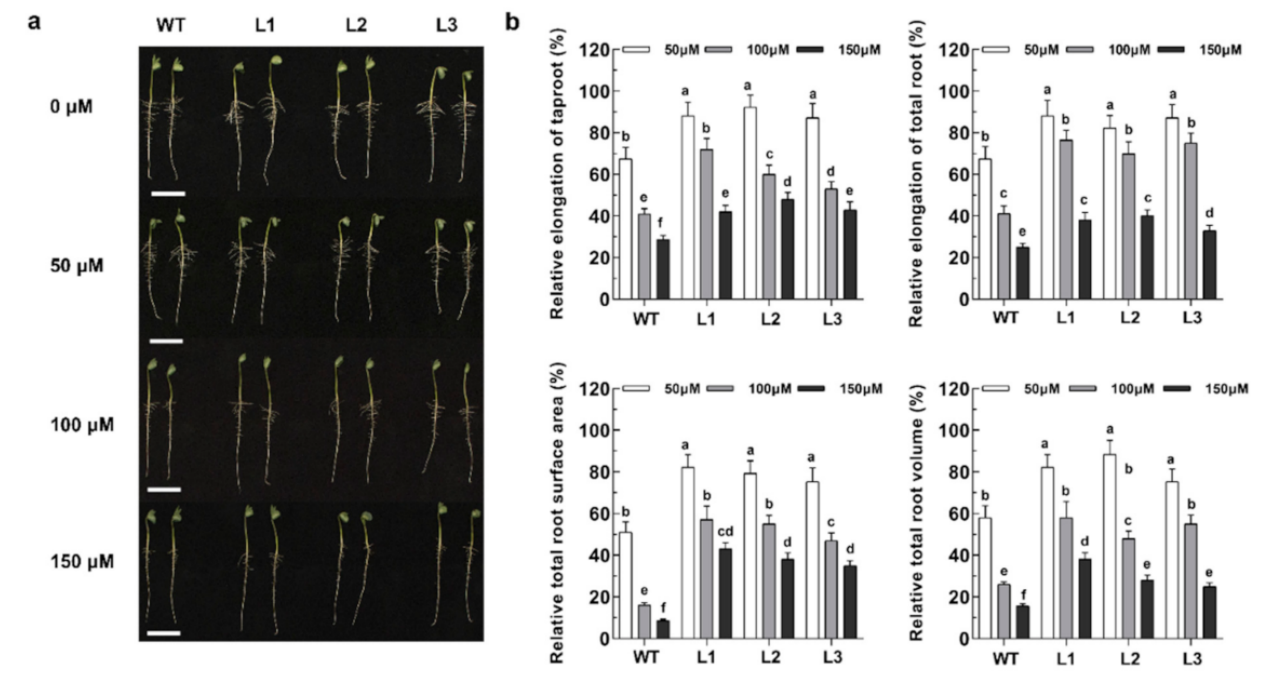
Figure 4. Phenotypic detections of the GsABCI1 transgenic soybean lines. ( a ) Morphological analysis of the roots of the WT and three transgenic lines (L1, L2, L3). ( b ) Analysis of relative taproot elongation, relative total root elongation, relative total root surface area, and relative total root volume in the WT and three transgenic lines (L1, L2, L3). Soybean seedlings with consistent growth were identified and transferred into a 0.5 µ M CaCl 2 hydroponic solution (pH 4.5) containing 0, 50, 100, or 150 µ M AlCl 3 for 12 h. Photograph taken, scanned, and acquired data through Image J. Bar = 5 cm. The data are the means ± SDs ( n = 16). The different letters indicate significant differences at p < 0.05 as determined by Student’s t